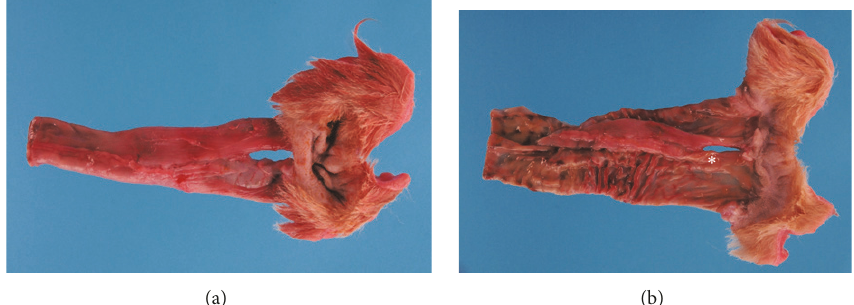
Figure 5: Colon and rectum. (a) Serosal surface and external anal orifices. (b) Mucosal surface and external anal orifices. The mucosal surface of the colon was completely duplicated with a septum ( ∗ ) which extended 4.5 cm orally before joining to one colon.